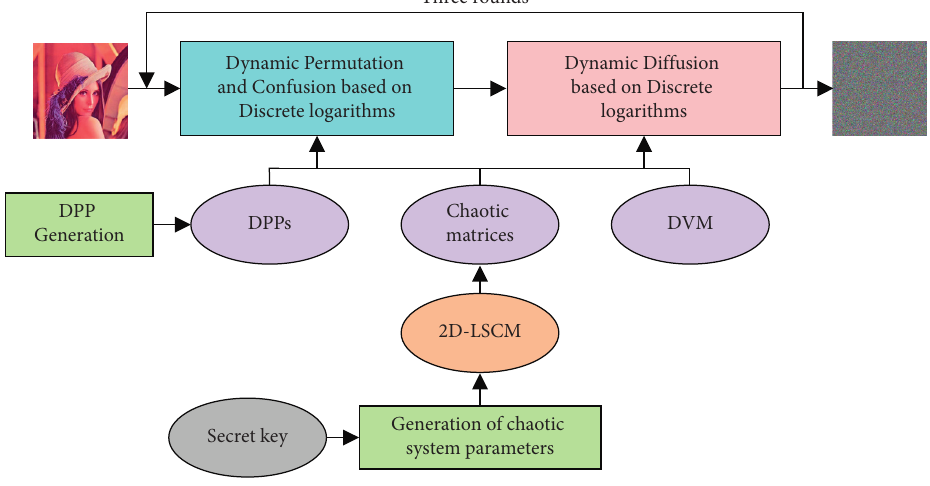
Figure 5: Flowchart of